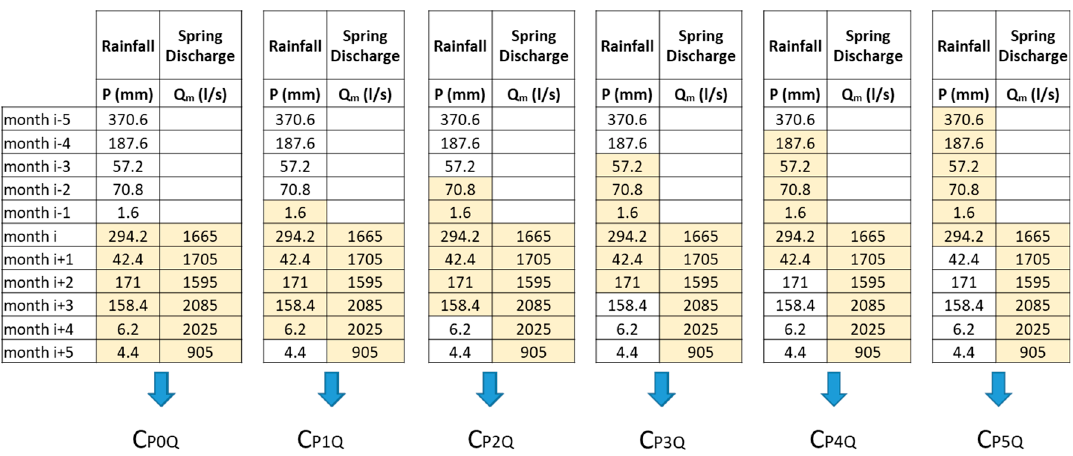
Figure 4. Graphical representation of the schematic procedure for C PiQ correlation coefficients determination.